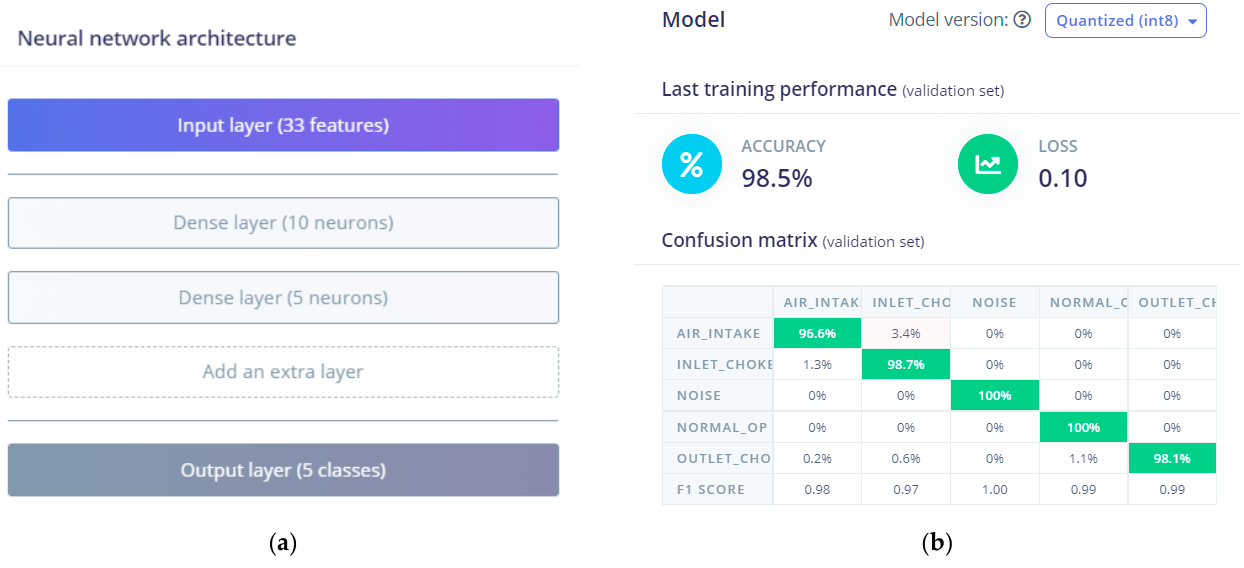
Figure 7. ( a ) The ANN model structure and ( b ) expected accuracy using the Edge Impulse platform.